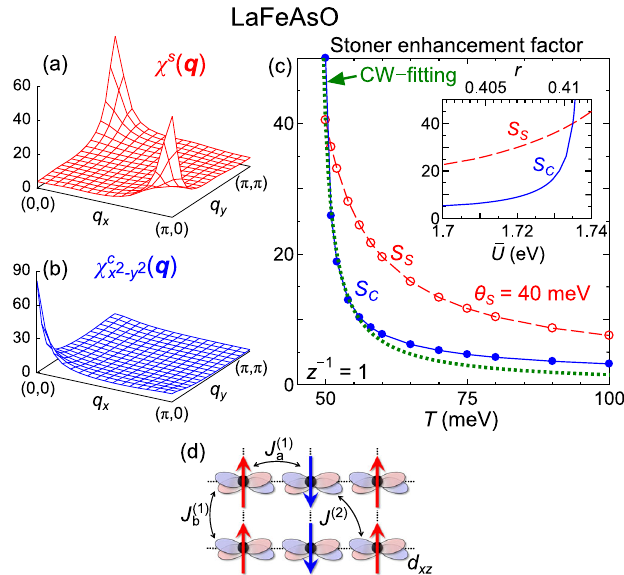
FIG. 2. (a) χ s ð q Þ and(b) χ c ð q Þ obtainedbytheSC-VCmethod x 2 − y 2 forLaFeAsO ( z ¼ 1 ). Note that other FOsusceptibility[ χ c ð q Þ ] and z 2 antiferro-orbital susceptibilities [ χ c ð q Þ ] also develop second- xz=yz as a function of T arily. (c) Orbital (spin) enhancement factor S C ð S Þ for LaFeAsO ( z ¼ 1 ) at r ¼ 0 . 41 . The charge and spin Weiss 48 meV and θ 40 meV, respectively. temperatures are θ C ¼ S ¼ ¯ U Inset: S as a function of r at T ¼ 50 meV. Note that ¼ C ð S Þ 4 . 23 r eV for LaFeAsO. (d) Orbital-spin interplay in the localized ( d , d )-orbital model, known as the Kugel-Khomskii xz yz χ c ð q Þ are shown in Figs. 2(a) and 2(b), respectively, x 2 − y 2 ¯ U ¼ 1 . 74 eV) at T ¼ 50 meV. Here, the for r ¼ 0 . 41 (